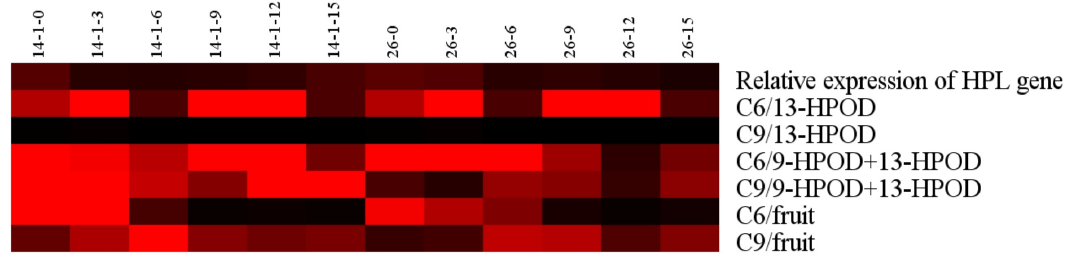
Figure 7. The heat map about the CsHPL gene expression, enzyme activity of fruit identified by the catalytic action of crude enzyme extracts incubating with n -HPODs and aldehyde production during fruit development in both lines. Relative expression levels of the CsHPL gene, C6 or C9 content at each sample point are shown by the colour scale. The lowest content levels are in black, and the highest in red. 14-1-0 to14-1-15 refer to the six developmental stages of fruits in No. 14-1 lines, and 26-0 to 26-15 refer to the six developmental stages of fruits in No. 14-1 lines. C6/13-HPOD (C9/13-HPOD): C6 (C9) aldehyde contents produced using 13-HPOD as a substrate during cucumber fruit development in two lines; C6/9-HPOD + 13-HPOD (C9/9-HPOD + 13-HPOD): C6 (C9) aldehyde contents produced using 13-HPOD and 9-HPOD mixture as a substrate during cucumber fruit development in two lines. C6/fruit (C9/fruit): C6 (C9) aldehyde contents produced during fruit